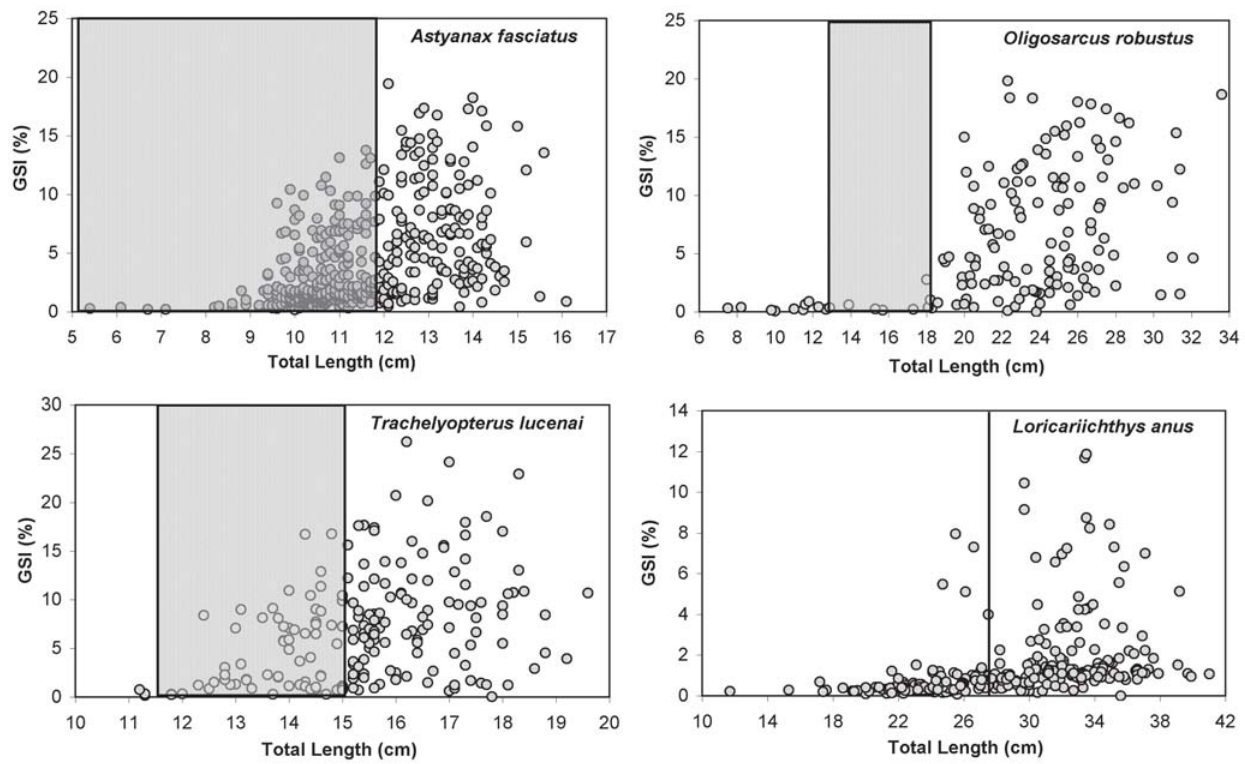
Fig. 3. Individual distribution of female gonadossomatic index (GSI) according to the total length in four fish species. Animals captured using seine and gill nets over 17 monthly samples (November/2002 to May/2004) from two sites (lagoa do Casamento and lagoa dos Gateados, Rio Grande do Sul State, Brazil). Vertical lines or areas represent published estimates of size at first maturity (L 50